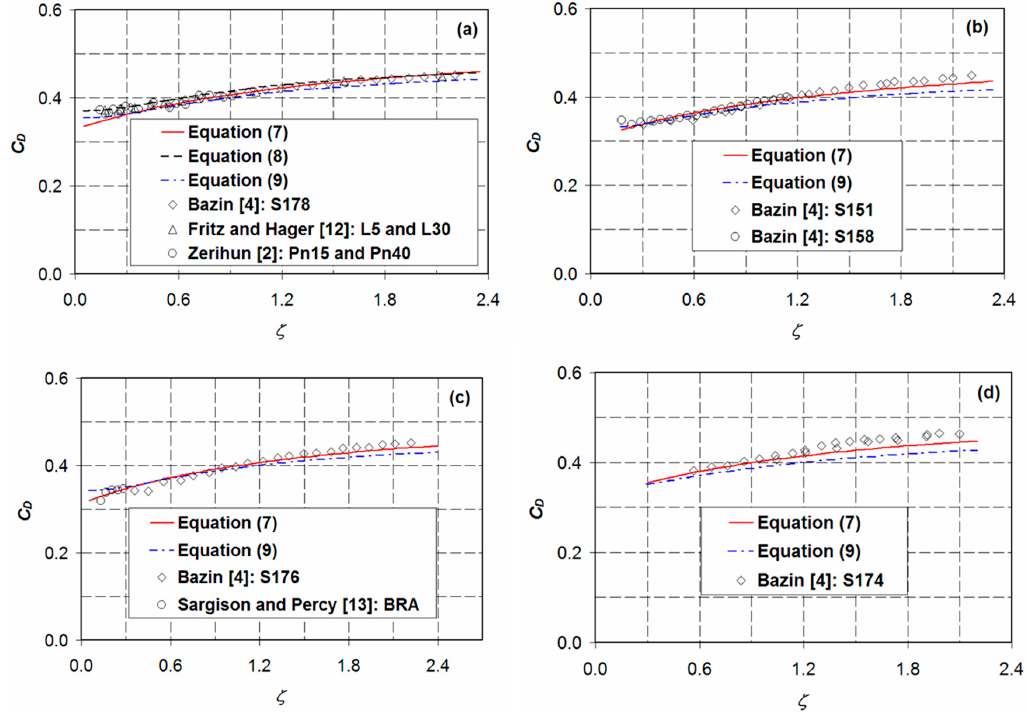
Figure 7. Discharge coefficients for hydraulically smooth trapezoidal-shaped weirs with various combinations of upstream- and downstream-face slopes [ θ , ϕ ]: ( a ) [26.57 ◦ , 26.57 ◦ ]; ( b ) [63.43 ◦ , 26.57 ◦